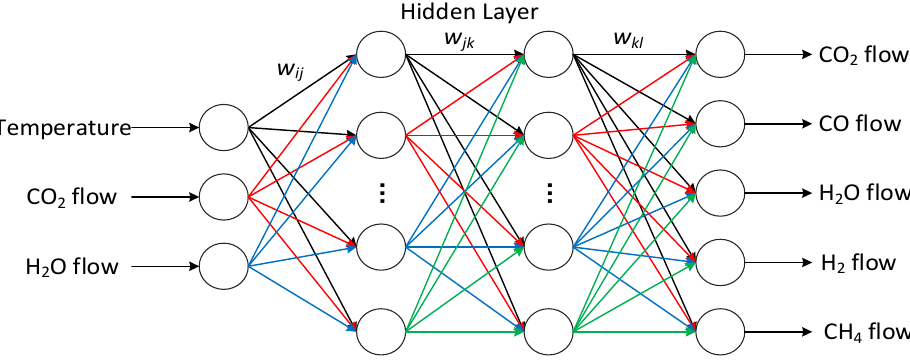
Figure 1. Basic structure of ANN model for product prediction of methane reforming.